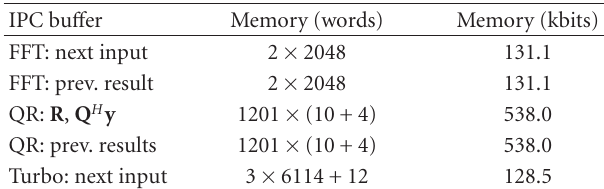
Table 6: Additional bu ff er memory requirements for seamless